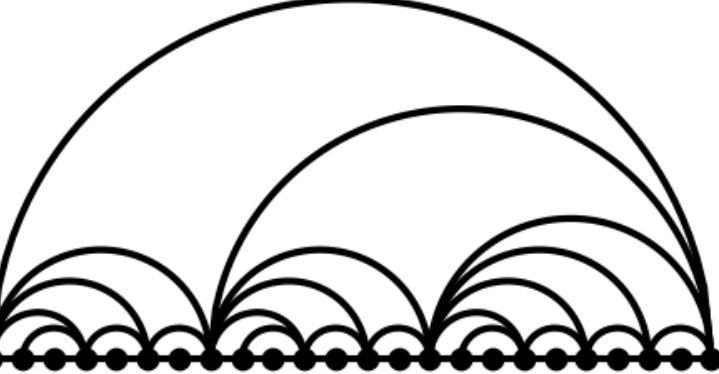
Figure 2. Haros graph G 10/23 . As 10/23 = [ 2,3,3 ] , it is clear that the binary symbolic path to reach this Haros graph is LLRRRLL = L 2 R 3 L 3 − 1 . According to the boundary node convention, the extreme nodes are identified as a single boundary node, while the total number of degrees is